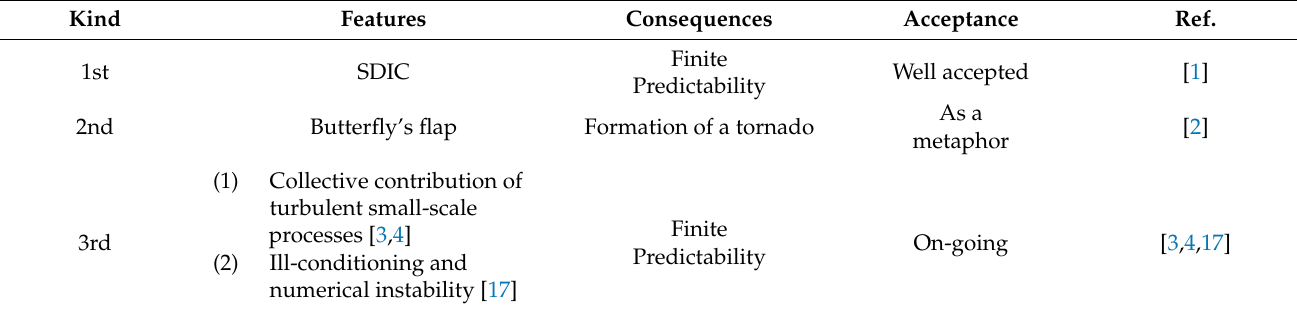
Table 1. The Three Kinds of Butterfly